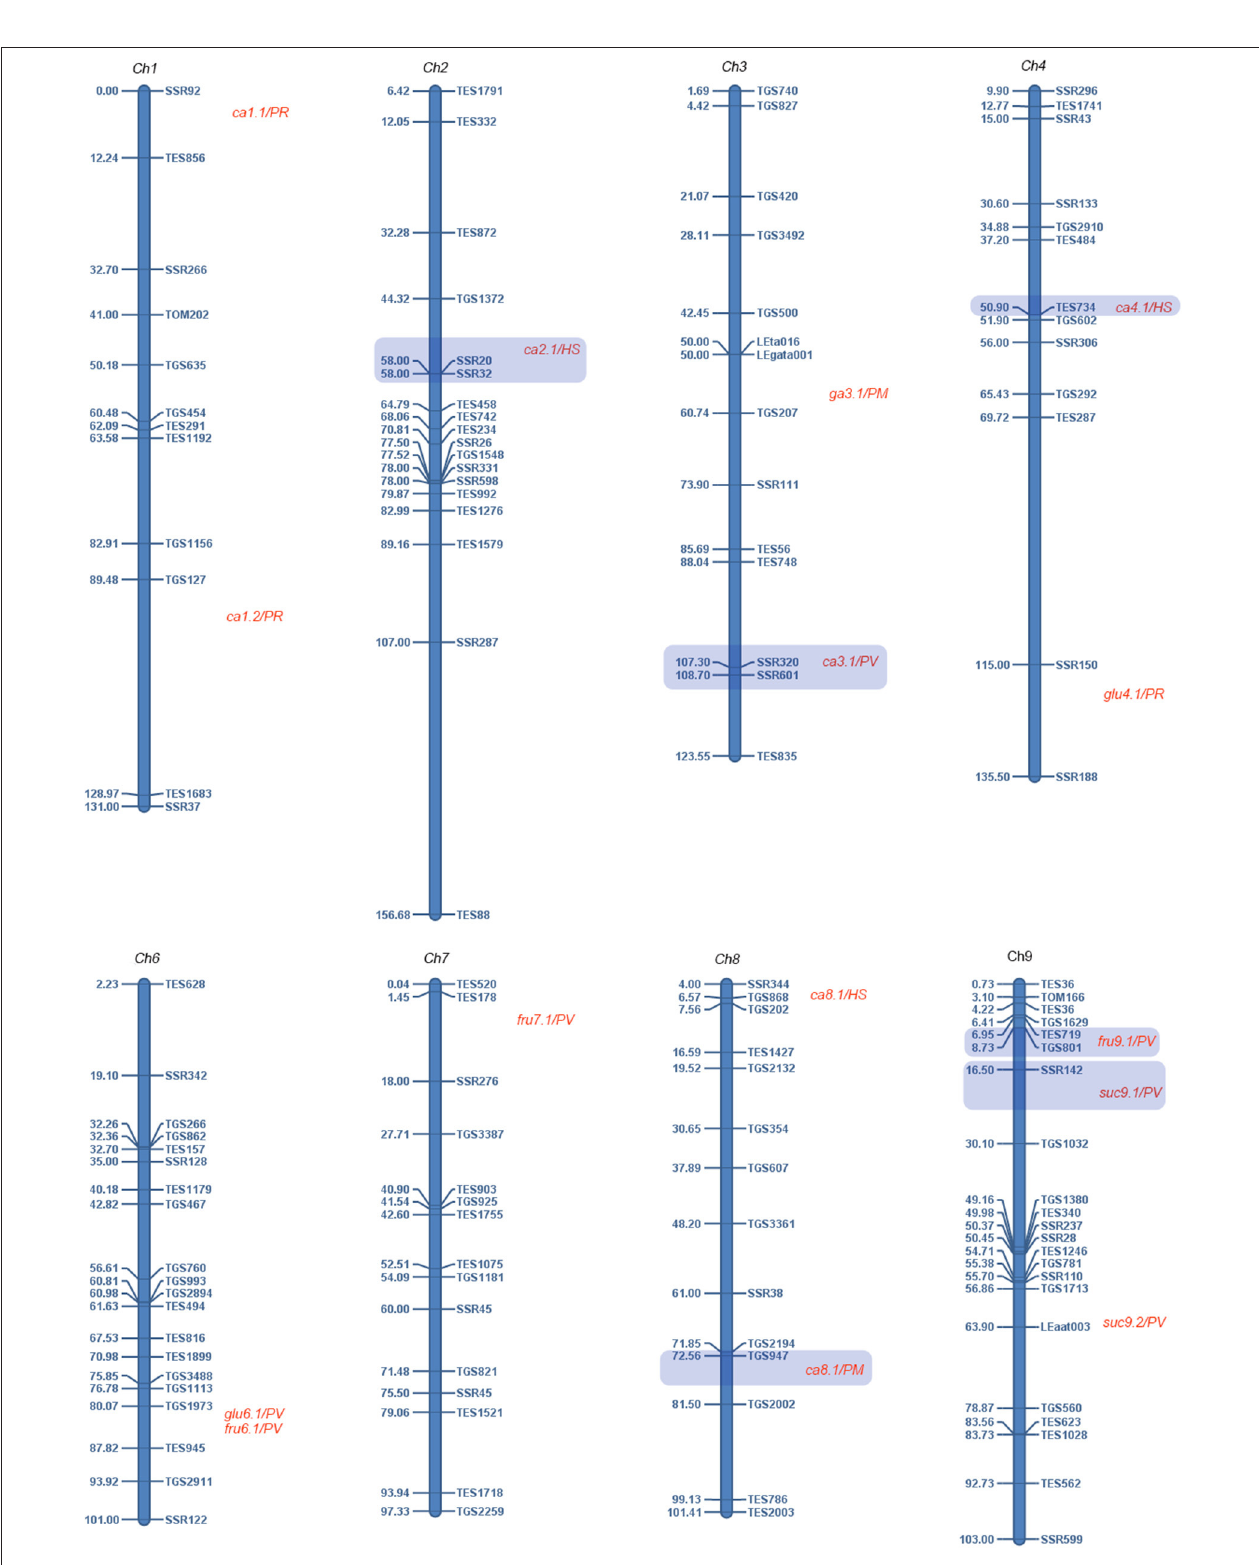
FIGURE 2 | Comparison of significant associations and co-localized QTLs identified by linkage mapping. The names and Positions of SSRs are showed on the right and left of the chromosomes, respectively. Co-localized QTLs are mainly reported in Fulton et al. (2002). Fru, fructose; glu, glucose; suc, sucrose; ca, citric